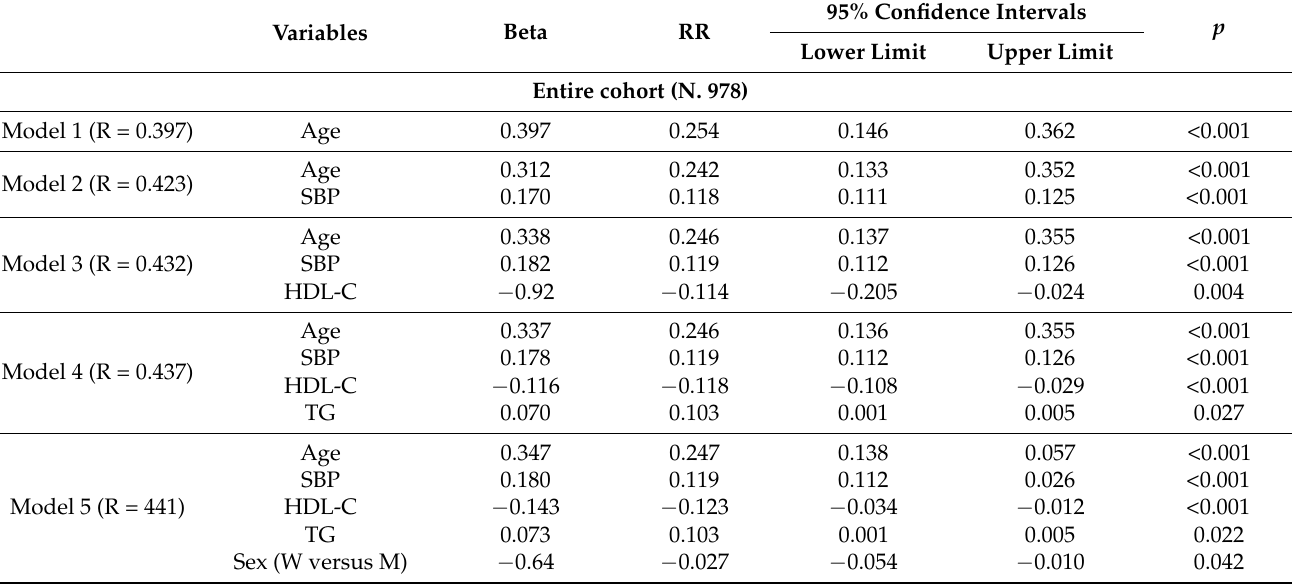
Table 4. Multiple linear regression models predicting cfPWV in the entire population cohort and in the pre-defined subpopulation